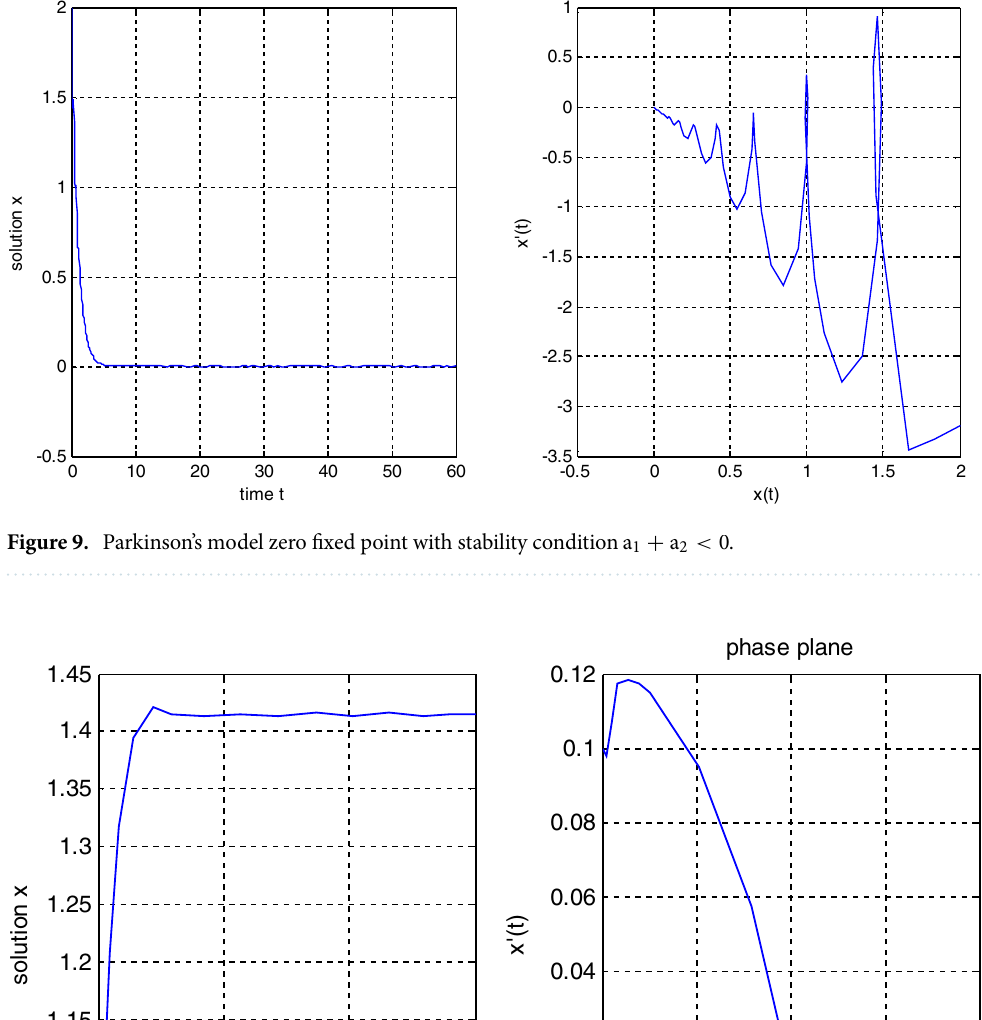
Figure 10. Parkinson’s model non-zero fixed point = √ 2 with stability condition a 1